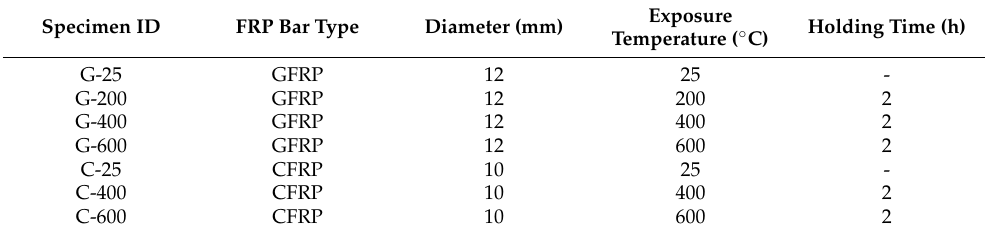
Table 1. Summary of all FRP-reinforced concrete beam specimens used in this